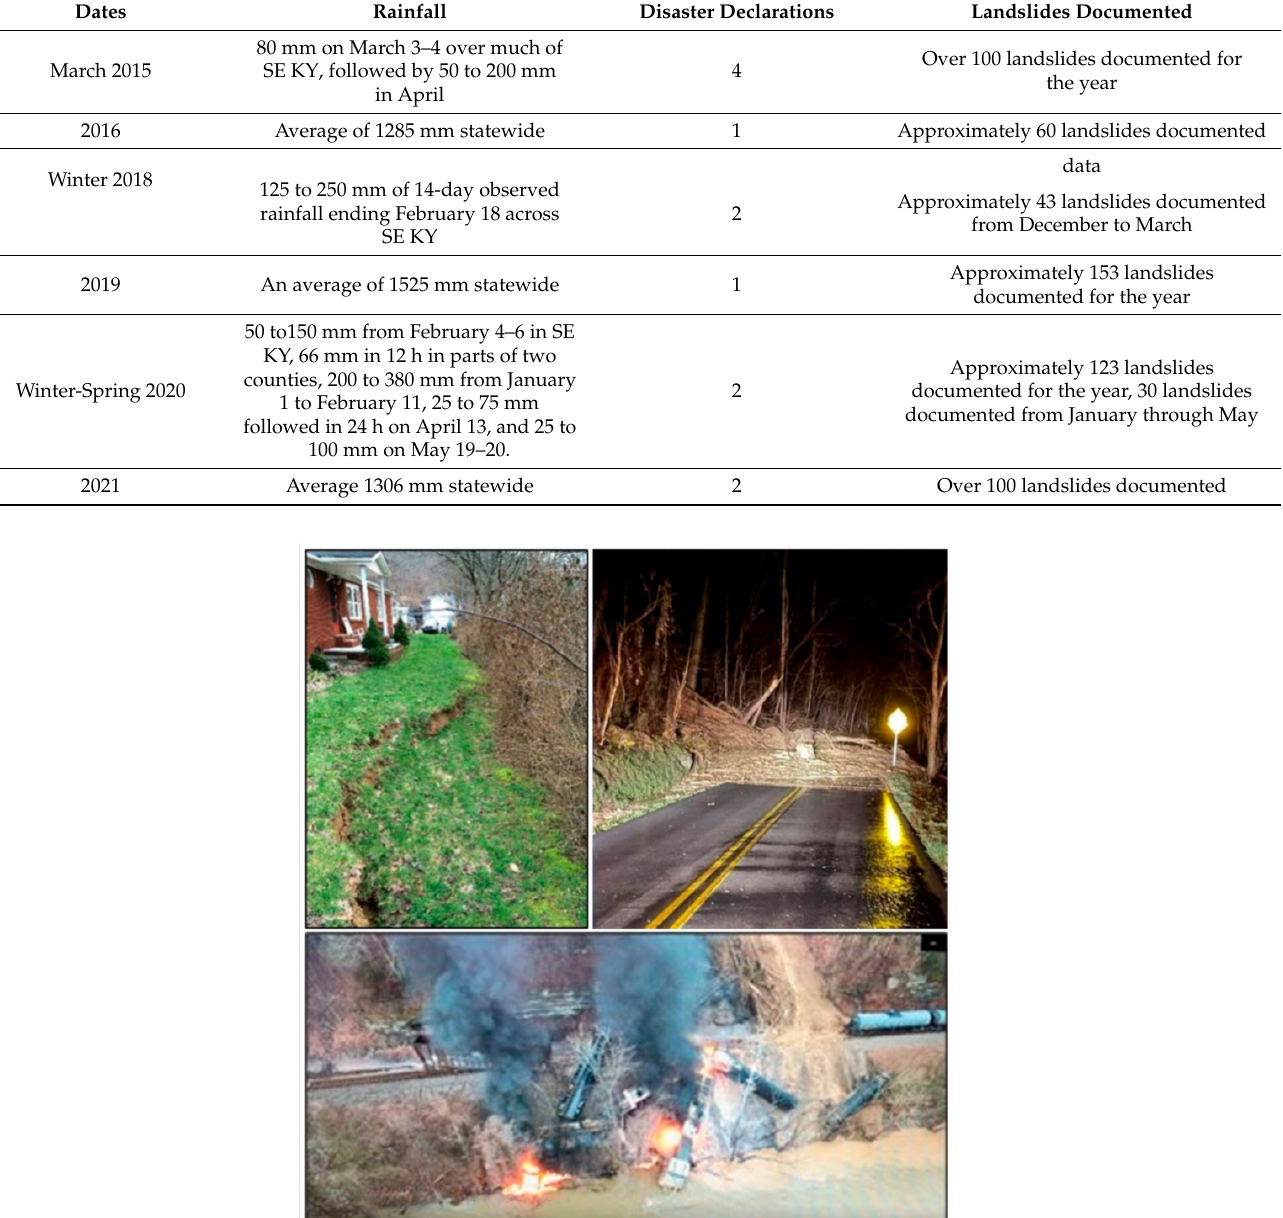
Table 1. Rainfall and related FEMA-designated presidential disaster declarations in Kentucky (KY) from 2015 to 2021. Documented landslides from the Kentucky Geological Survey inventory database.